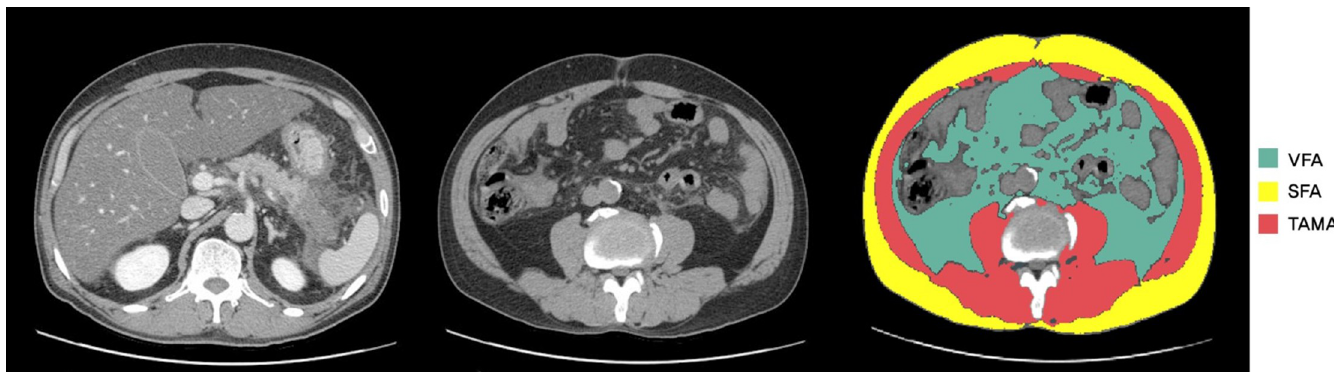
Fig 1. Computed tomography (CT) findings and body morphometric evaluations of abdominal fat and muscle areas in an acute pancreatitis patient (M/56) who had consumed more than 47 g daily. (A). A portal phase CT image showing necrosis, edematous change, and peripancreatic fluid collection in the pancreatic tail. (B/C) Noncontrast and mapped CT images obtained using DeepCatch R at the same level of the inferior endplate of the L3 vertebra. (C) Segmented axial CT image showing visceral fat area (VFA, cm 2 ), subcutaneous fat area (SFA, cm 2 ), and total abdominal muscle area (TAMA, cm 2 ) for psoas, paraspinals, transversus abdominis, rectus abdominis, quadratus lumborum, and internal and external obliques.